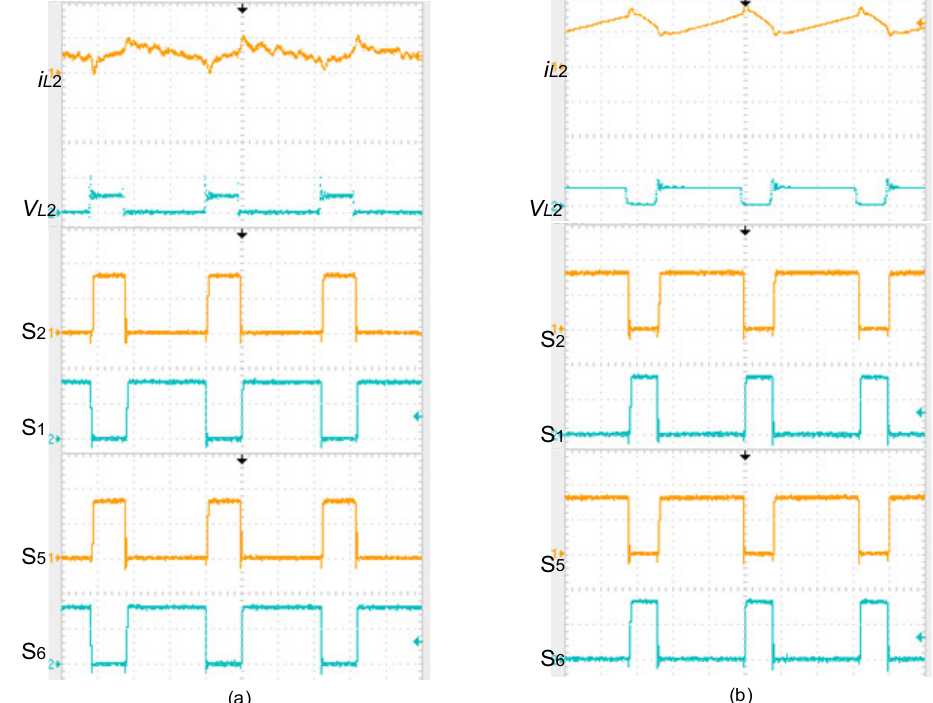
Figure 12. Scope results showing the inductor L 2 current and voltage alongside the associated switching signals of the MOSFETs for operating the multiple input converter in Mode B at ( a ) 30% duty and ( b ) 75% duty.